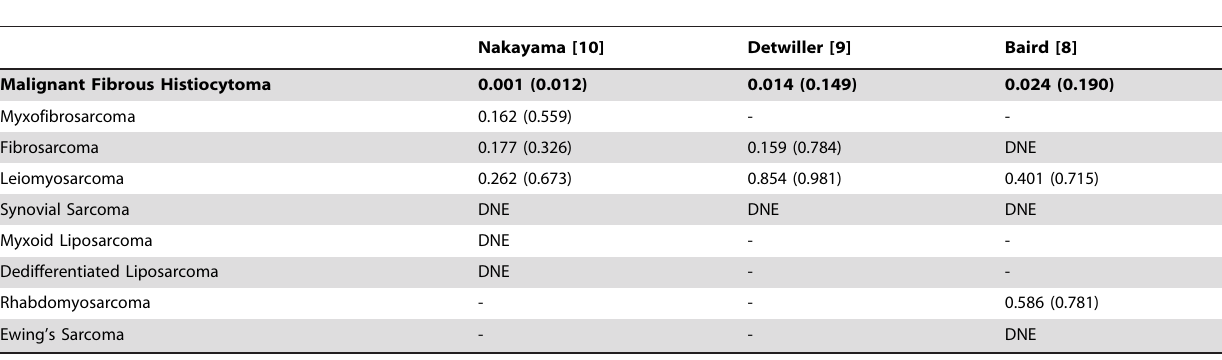
The mouse sarcoma geneset was used to examine three human soft tissue sarcoma datasets [8,9,10]. Only undifferentiated pleomorphic sarcoma/MFH demonstrated statistically significant enrichment. Table denotes p-values with FDR in parentheses. Bolded results note significance with p , 0.05; FDR , 0.25. DNE=Did Not Enrich, dash marks represent insufficient data points to do comparison.